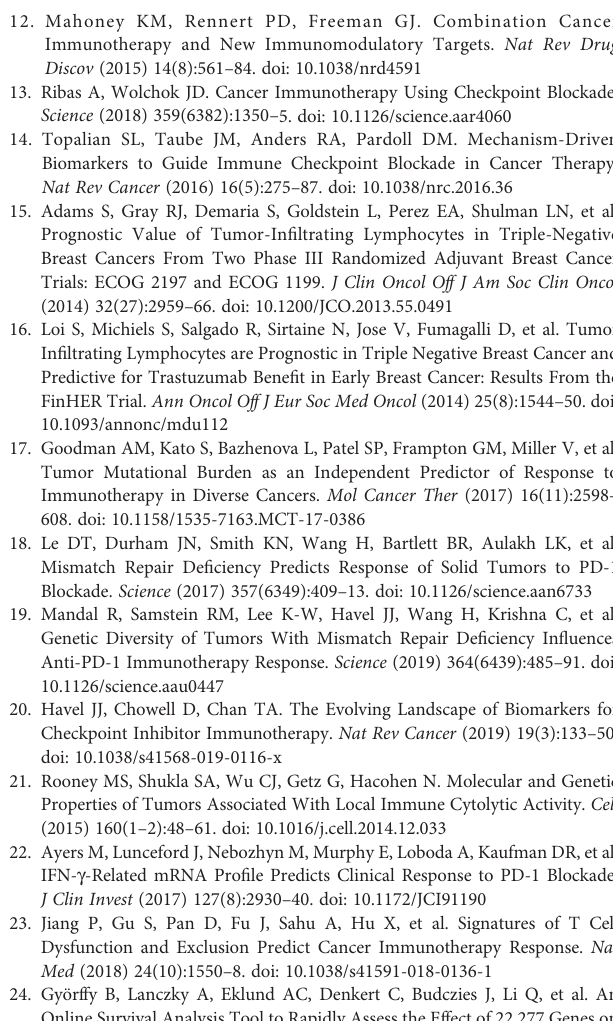
Supplementary Figure 1 | Clinical outcome analysis of CD2 , CD3D , CD3E , CXCR6 immune gene signature expression in lung SCC and esophageal SCC tumors. Clinical outcomes of survival plots of new immune gene signature with no prediction at all stages of lung SCC tumors (n = 501) (A) and poor prognosis at all stages in esophageal SCC tumors (n = 81) (B) are displayed. Red line represents survival of patients whose tumors harbor high gene expression levels, and black line represents those with low gene expression levels. Number of patients at risk at every time (months) is displayed. HR for risk of death and overall survival (OS) are displayed. HR < 0.65 discriminates a risk reduction. FDR is also displayed. The gene combination is displayed at the top of each fi